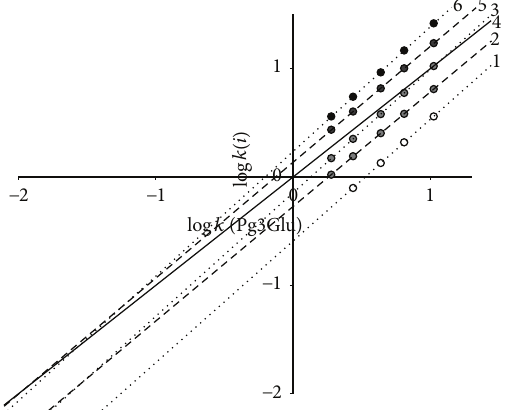
Figure 3: Separation map of 3-glucosides of six common antho- cyanins:Dp3Glu(1);Cy3Glu(2);Pg3Glu(3);Pt3Glu(4);Pn3Glu(5); and Mv3Glu (6). System 1. Chromatographic column: 4.6 × 250 mm Symmetry C 18 .